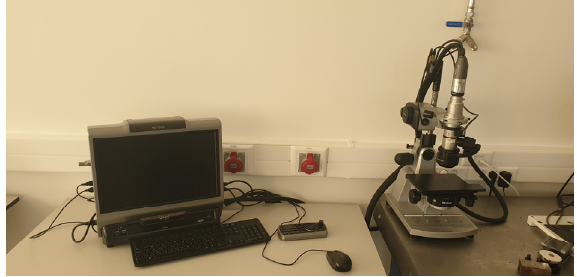
Figure 4. Keyence VHX-1000 digital microscope, which was used for measuring the wear scar dimensions on the